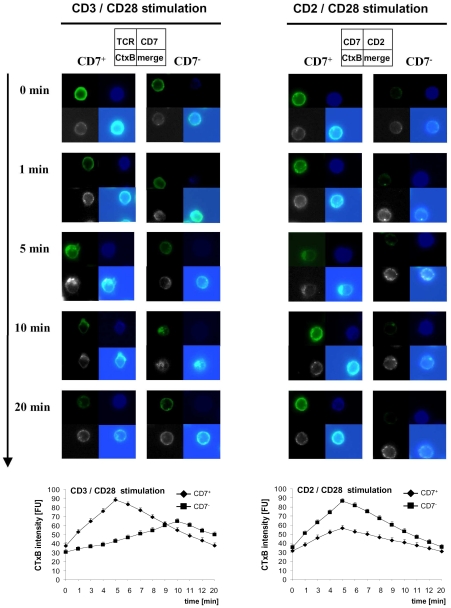
TCR synapse formation is impaired in late-stage T cells.CD8+ CD45RO+ T lymphocytes were incubated on coverslips coated with the agonistic anti-CD3 mAb (UCHT-1) plus anti-CD28 mAb (CD28.2) or with the anti-CD2 mAbs (L303.1) and (L304.1) plus the anti-CD28 mAb (CD28.2). Cells were activated for various time intervals (1 min until 20 min), incubation was stopped by addition of paraformaldehyde, and cells were stained with TCR-alpha/betamAb (green) plus CD7 mAb (blue) or alternatively with CD2 mAb (blue) plus CD7 mAb (green) together with cholera toxin B (CtxB) (white) for lipid raft staining. Cells were analyzed on a LSM 510 with 630× microscope magnification. A minimum of 100 cells for each data point was recorded. Representative images after 0 min, 1 min, 5 min, 10 min and 20 min stimulation out of five independent experiments are shown. Synapse formation intensity (CTxB intensity) was quantified as described in Materials and Methods. A minimum of 100 cells of each cell population on each coverslip was recorded. Data represent mean scores from five experiments ± standard error of the mean and were compared using a paired t-test. * p<0.05. FU: fluorescence unit.